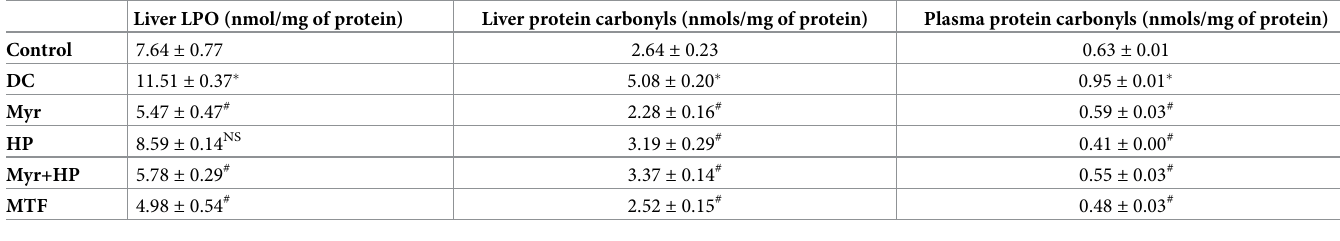
Table 5. Estimation of oxidative stress